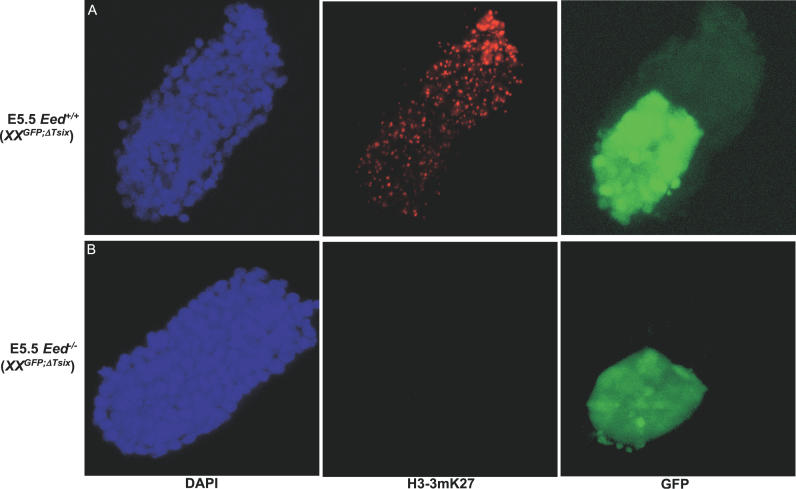
Enrichment of H3-3mK27 on the Xi during Initiation of Random XCI(A) IF detection in a WT E5.5 embryo showing Xi accumulation of H3-3mK27 in all cells of both the extraembryonic and embryonic lineages, i.e., the trophectoderm-derived extraembryonic ectoderm and the epiblast, which undergo imprinted and random XCI, respectively.(B) Eed
−/− embryos lack H3-3mK27.